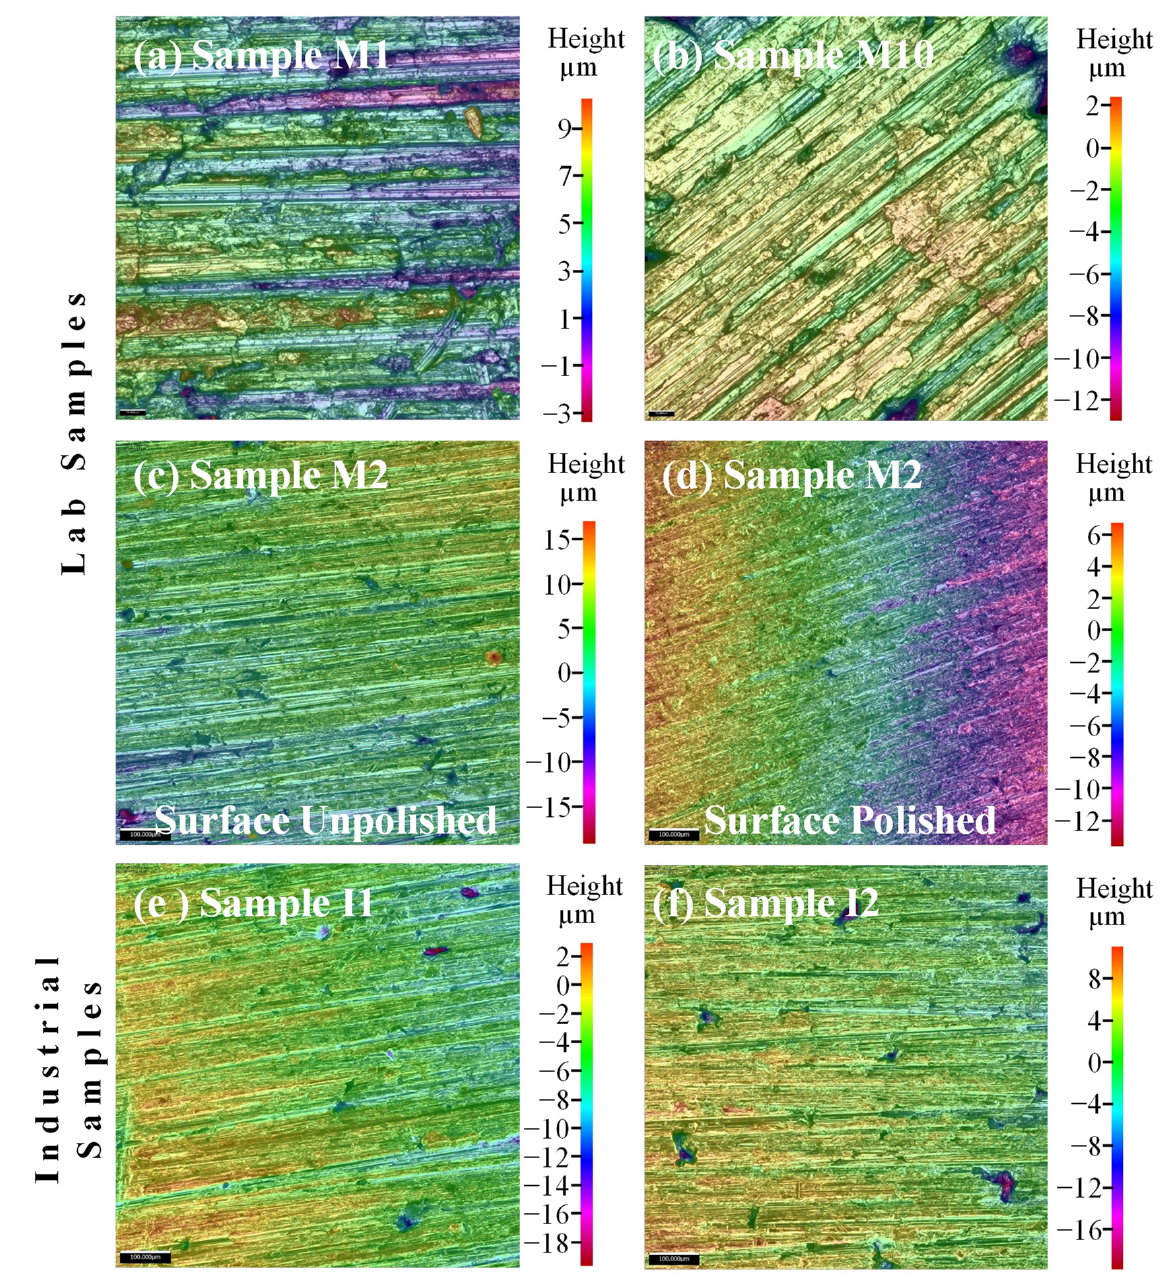
Figure 5. Mapping of the surface roughness for lab samples ( a ) M1, ( b ) M10, as well as for sample M2 with ( c ) surface unpolished, and ( d ) surface polished. Mapping of the surface roughness for samples produced under industrial scale process parameter values ( e ) sample I1, and ( f ) sample I2.